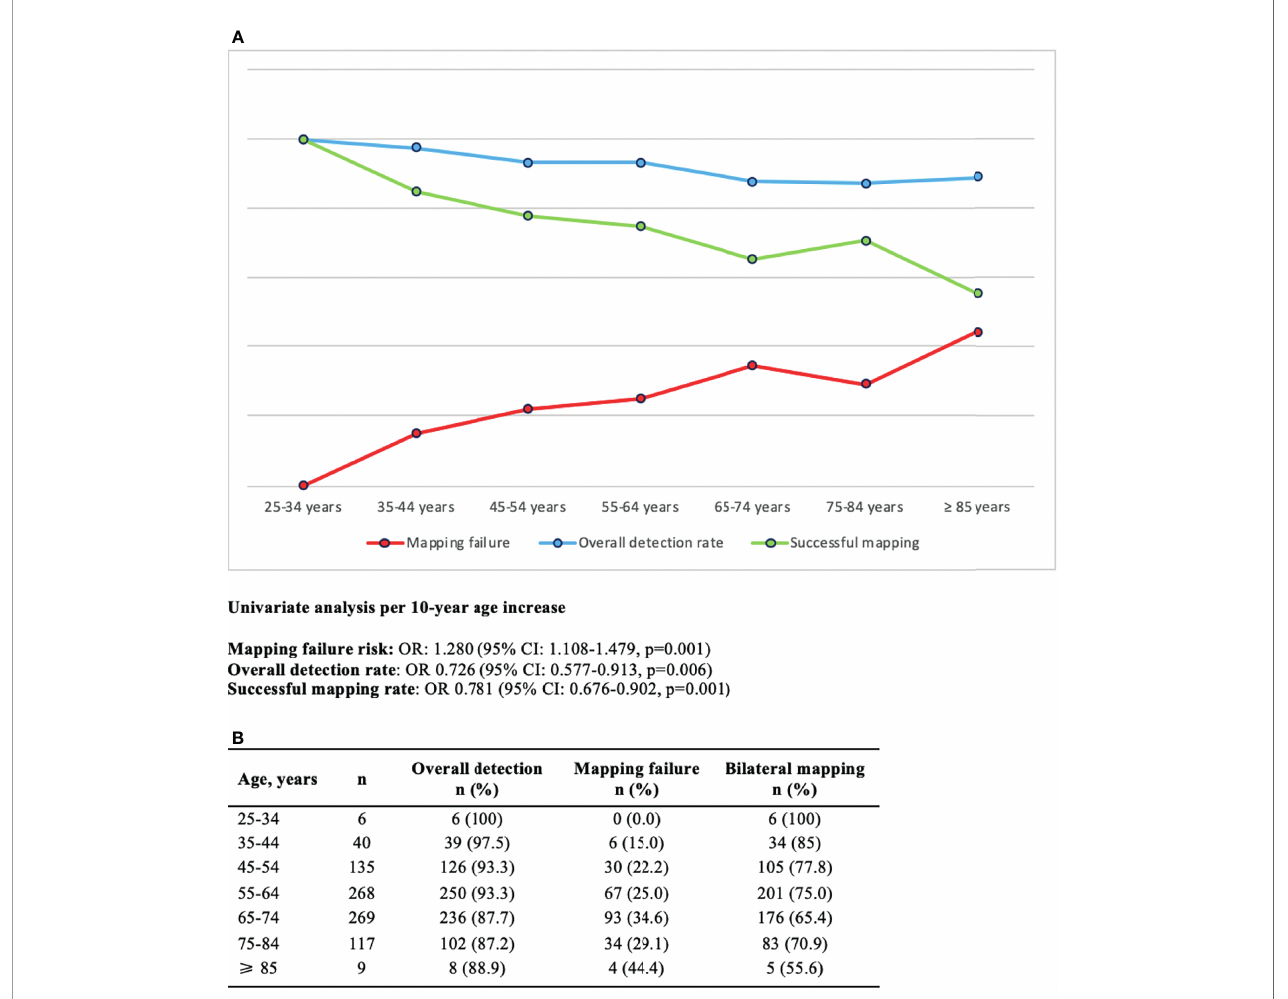
FIGURE 2 | (A) Graphical representation of SLN detection rates for 10-year age increase and corresponding binomial logistic regression analysis. (B) Frequency